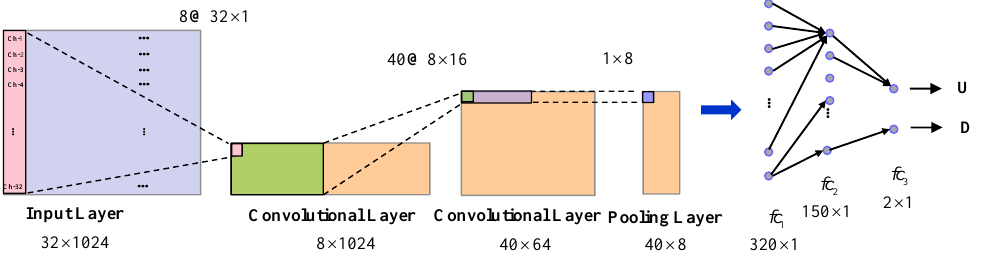
Figure 2. The architecture of the proposed CNN − based framework for the classification of lower − limb MI. U and D refer to lower − limb extension ( up ) and flexion ( down ),